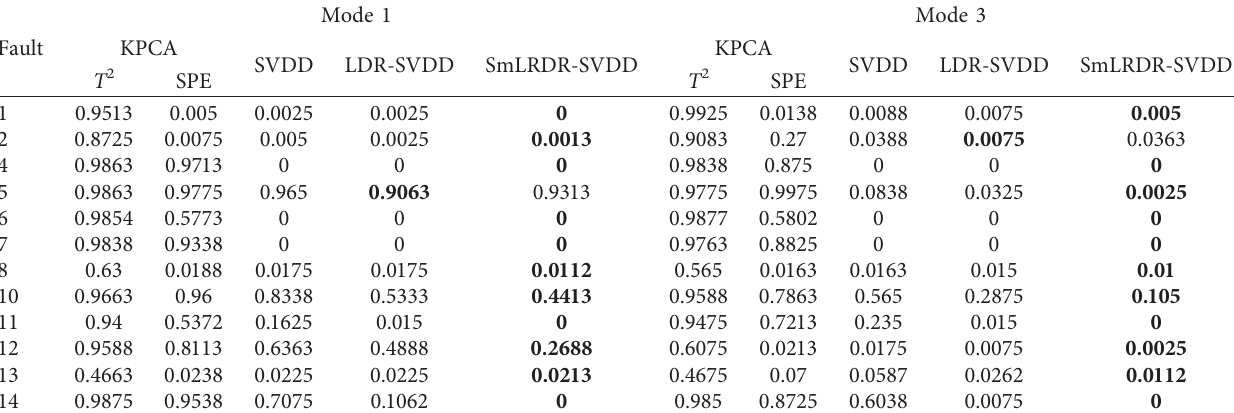
Table 3: MAR for all test conditions on TE process.